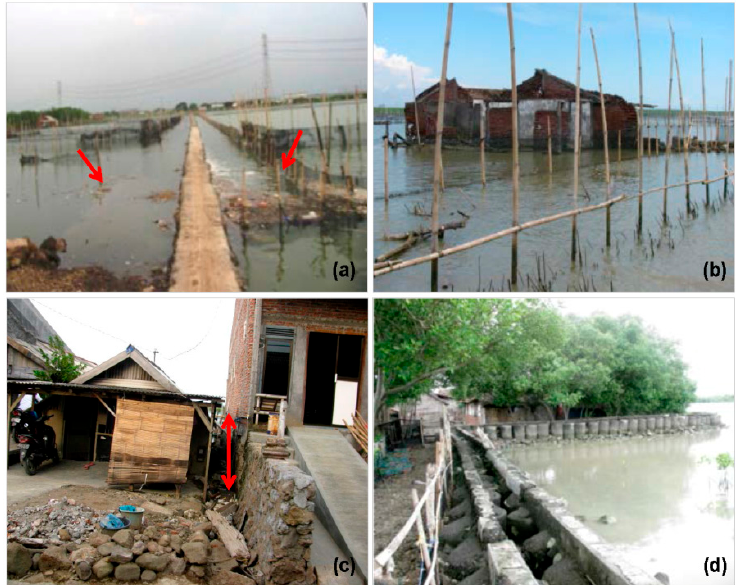
Figure 2. Some impacts of coastal erosion, inundation and subsidence in the study area: ( a ) Eroded land alongside the elevated road (red arrows show the initial width of the road); ( b ) inundated houses; ( c ) a house with an elevated floor; and ( d ) embankment and mangrove for coastal protection.